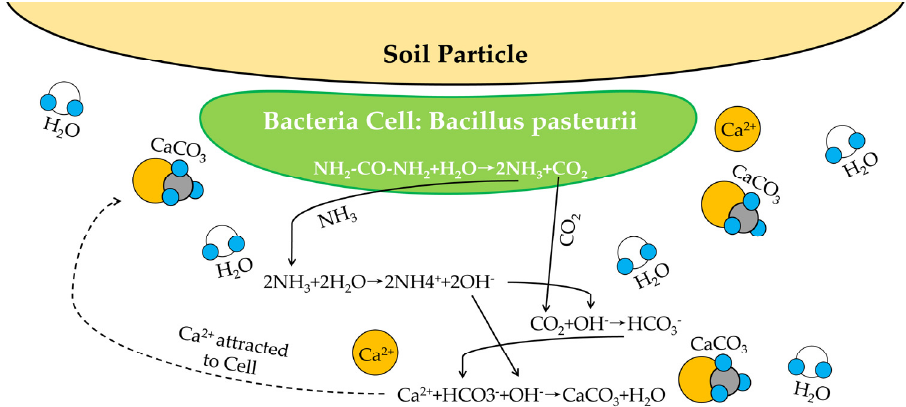
Figure 1. Sketch map of microbial-induced carbonate deposition process on particle surface.